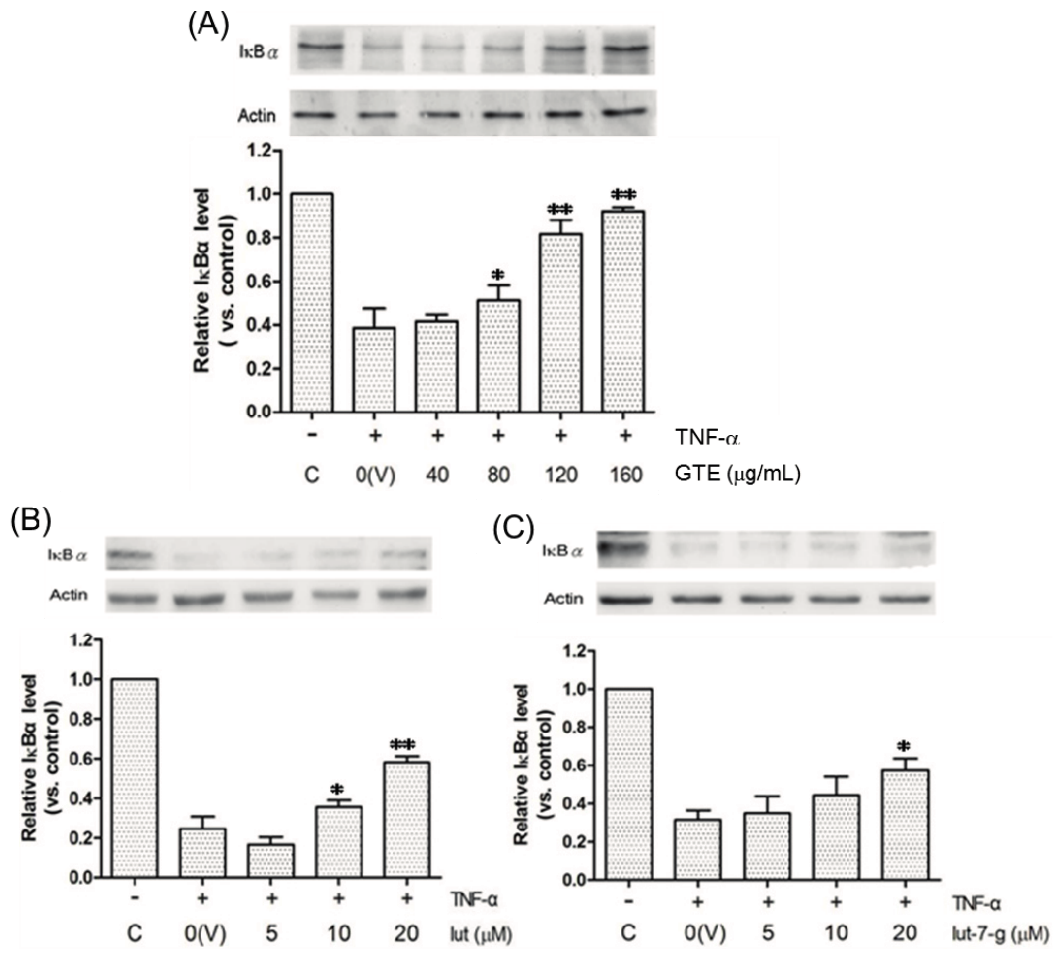
Figure 5. Inhibitory effects of ( A ) GTE; ( B ) lut; and ( C ) lut-7-g on the degradation of I κ B α . HUVECs were pretreated with vehicle only (V), GTE (40, 80, 120, 160 μ g/mL), lut (5, 10, 20 μ M), lut-7-g (5, 10, 20 μ M) and OA (5, 10, 20 μ M) for 2 h, and were then activated by TNF- α for 1 h. The whole-cell lysates were subjected to Western blot assays, using β -actin as an internal control. The relative density of the proteins was determined by densitometric analysis. A significant difference from the vehicle was indicated as, * p < 0.05, or ** p < 0.01 (Student’s t